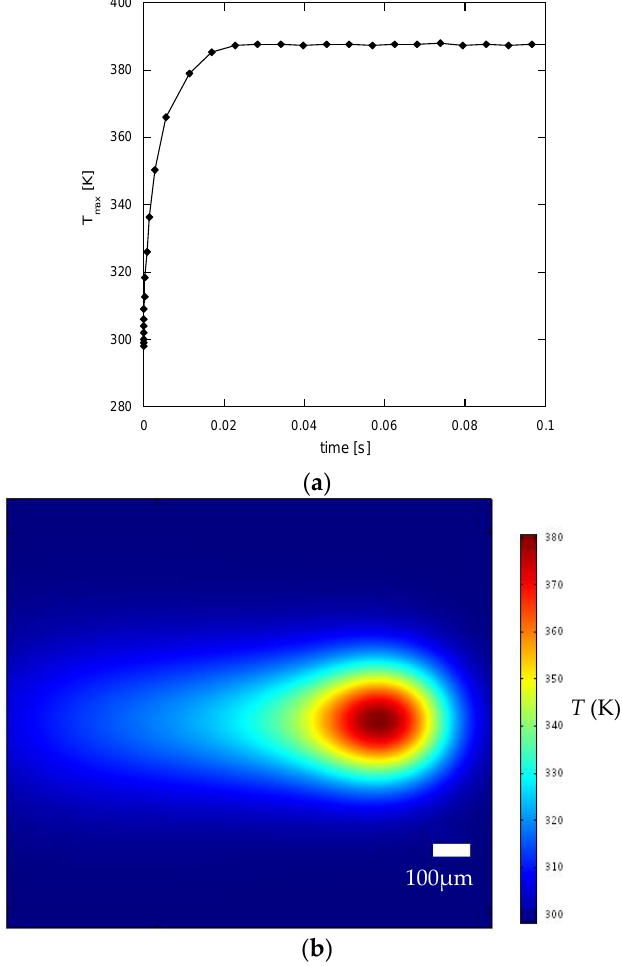
Figure 8. ( a ) The processing temperature for the first scan with respect to time along the scan path; ( b ) The simulated temperature profile on the polyimide